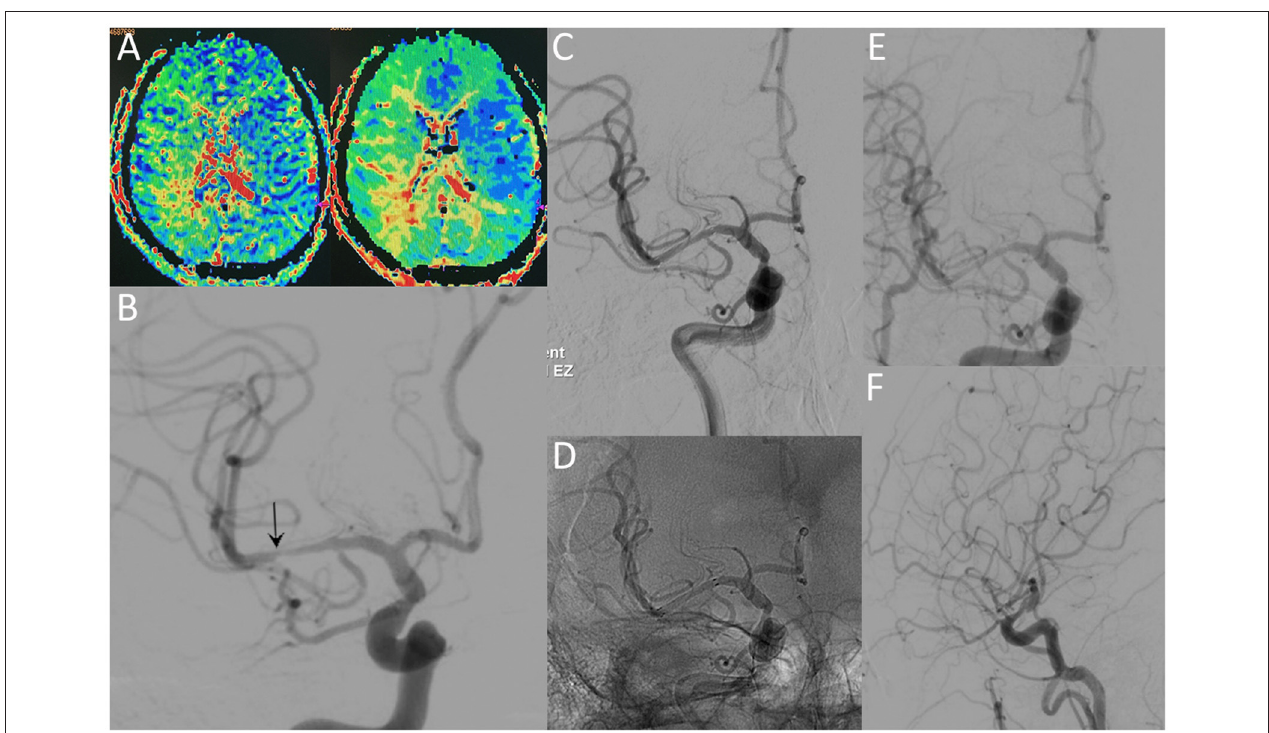
FIGURE 3 | A 36-year-old male with a significant stenosis in the right MCA. CT perfusion images (A) reveal a prolongation of MTT and TTP before the procedure. Preprocedural DSA image (B) demonstrates high-grade stenosis close to the MCA bifurcation (arrow). Postprocedural DSA images (C,D) reveal patency of the MCA without residual stenosis. The 12-month follow-up DSA images (E,F) reveal no ISR in the region of the originally stented lesion.